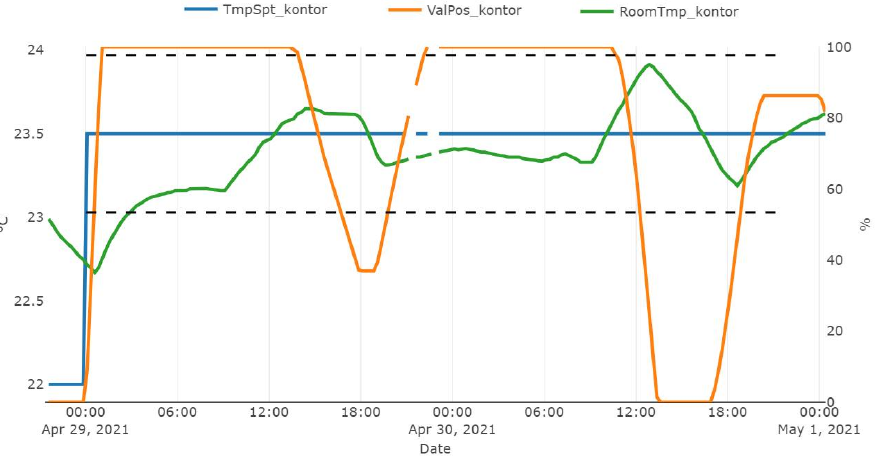
Figure 9. Time step response of the temperature